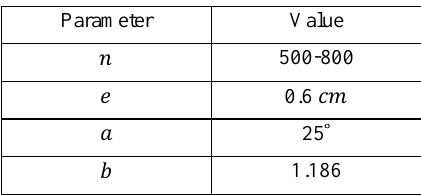
Table 1 . the values used for RANSAC in the simulations Fig. 6 and Fig. 7 shows results of applying RANSAC algorithm